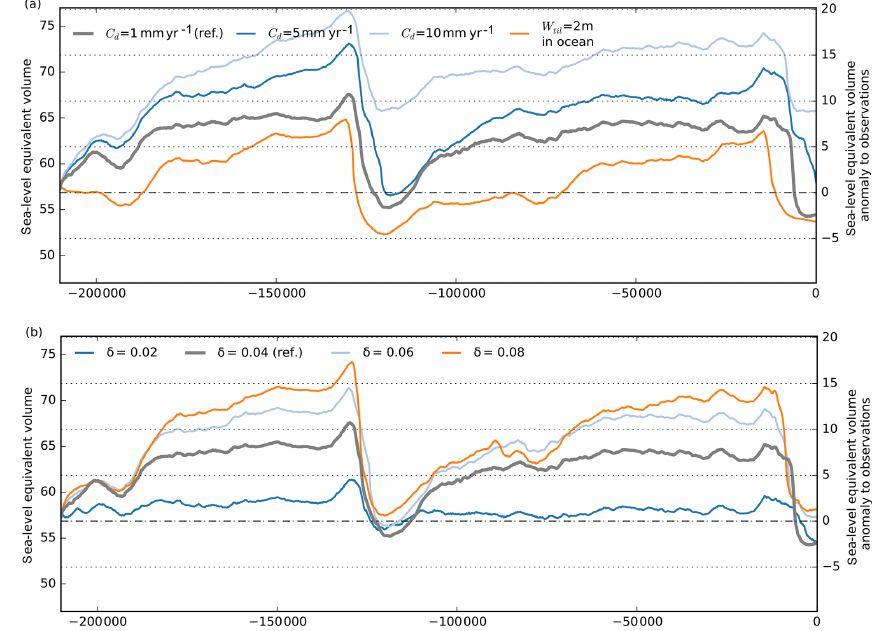
Figure 17. Simulation over two glacial cycles for different till water decay rates and for different fractions of the overburden pressure under- neath the grounded ice sheet. (a) Higher decay rates than the reference value of C d = 1mmyr − 1 (grey) cause less-extended ice streams, less ice discharge and hence thicker ice sheets (blue and light blue). When assuming maximum till water fraction across ocean beds, grounding- line advance of marine glaciers is decelerated. Accordingly, we find a less-extended and thinner ice sheet at glacial periods, earlier retreat, but similar present-day results (compare grey and orange lines). (b) The critical fraction of the effective overburden pressure δ has strong influence on the reconstructed ice volume, particularly at glacial maximum, with high parameter values leading to more friction and hence thicker ice sheets. For the evaluated range of 2%–8% we find up to 12mSLE difference in the ice volume above